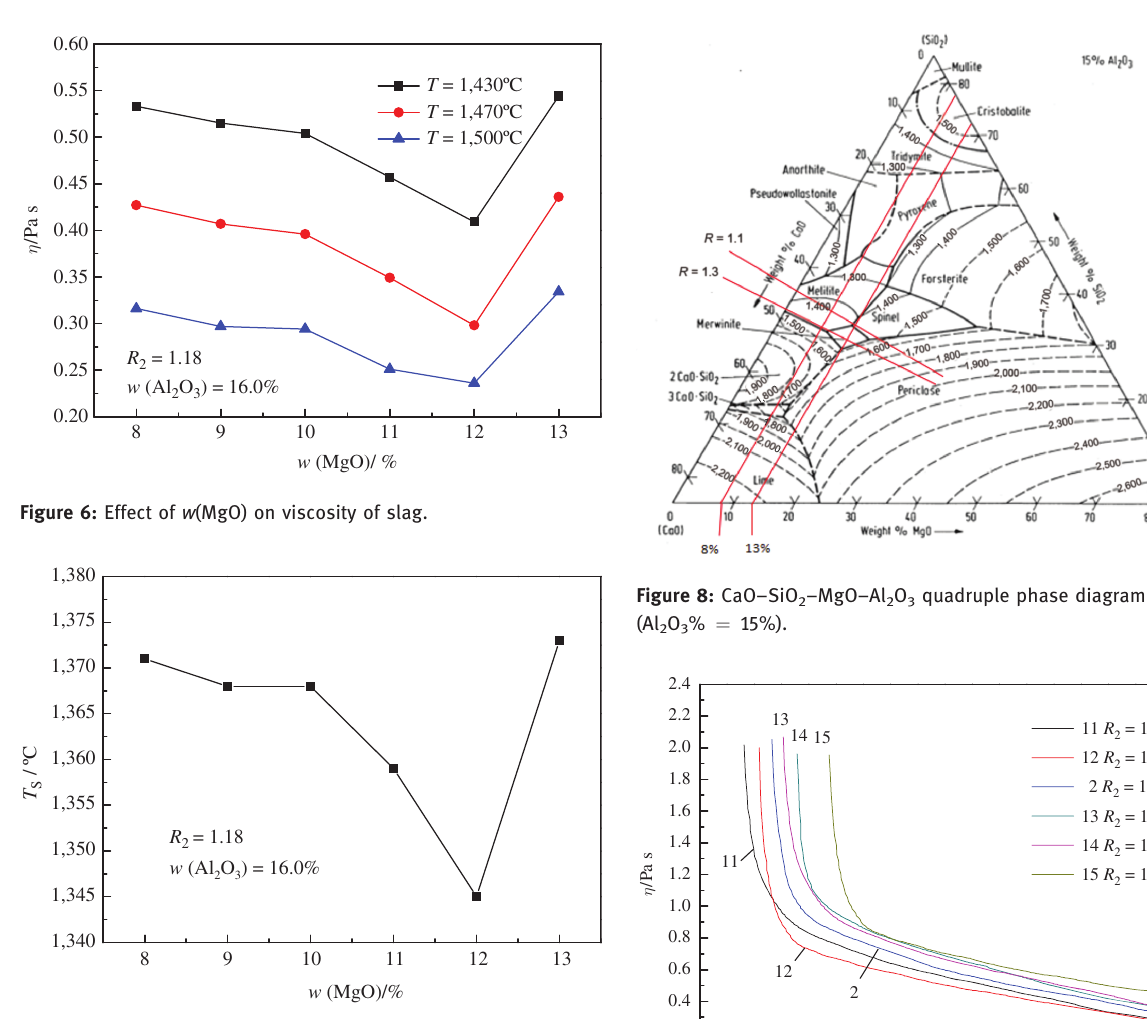
Figure 7: Effect of w (MgO) on T m of slag.